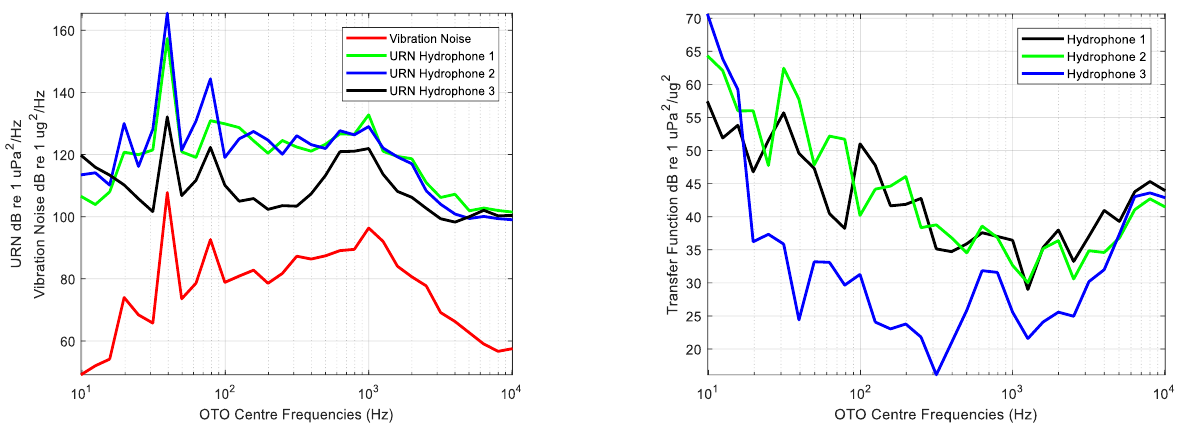
Figure 10. Broadband integration of the Vibration Noise in dB re 1 µg 2 /Hz and Underwater Radiated Noise in dB re 1 µPa 2 /Hz ( left ) and estimated Transfer Function dB re 1 µPa 2 /µg 2 for each hydrophone position ( right ).